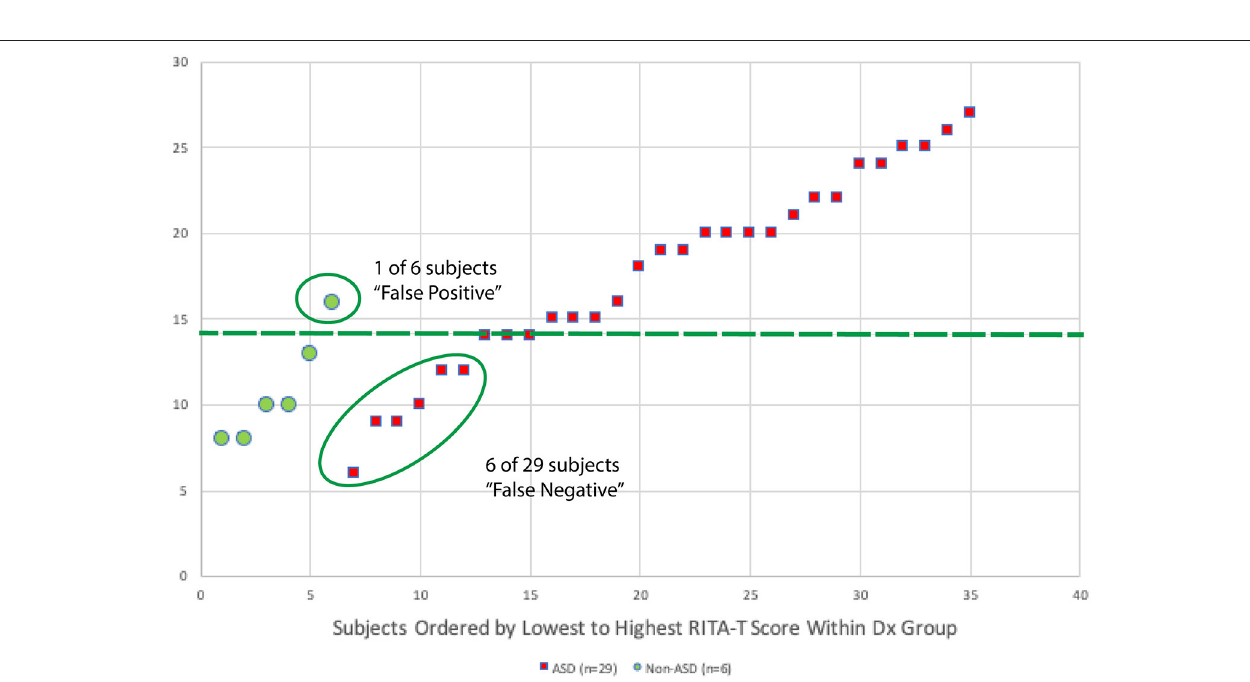
FIGURE 3 | A scatter plot with distribution for RITA-T scores of each participant is shown in this figure. Diagnosis of ADOS-2 is used to separate ASD and non-ASD groups. With 14 as cut-off score ( ≥ 14 for ASD), a total of 1 out of 6 was false positive and a total of 6 out of 29 were false negative. All 6 of the false positive cases are subjects in age group 37–84 months.